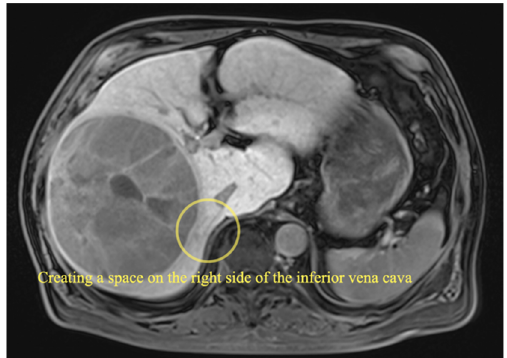
Figure 2. MRI image of giant HCC.